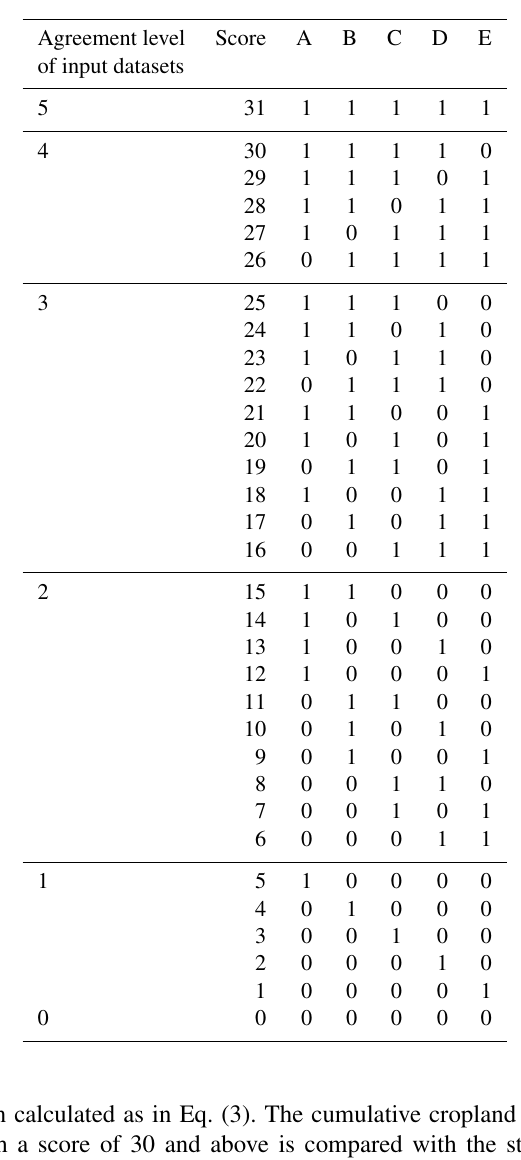
Table 2. The ranking scoring table for five input